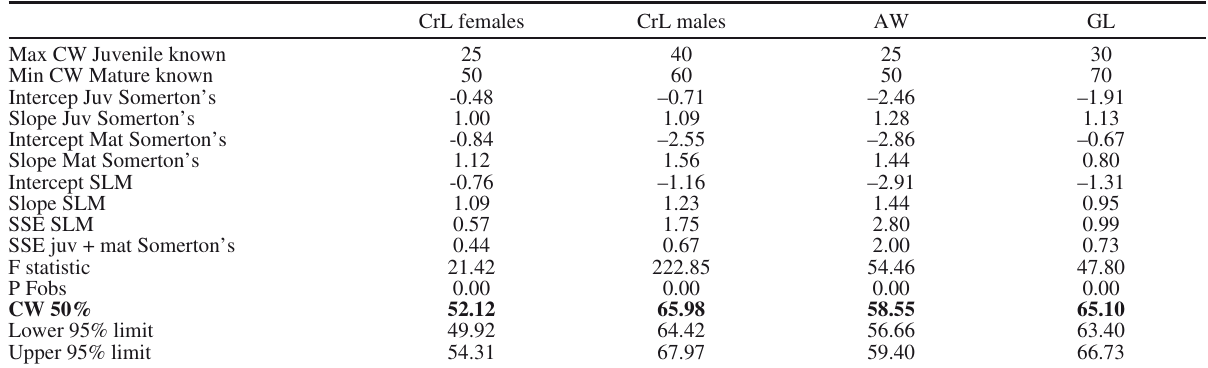
Table 2. – Summary of statistics and estimated parameters of the simple linear model and two-phase linear model (Somerton’s method fit- ted using the MATURE program) applied to the four morphometric characters used to estimate first maturity of both sexes of Platyxanthus crenulatus . SLM, simple linear model; SSE, sum of squared errors. Somerton’s immature or juvenile (Juv) and mature (Mat) are the first and second segments of the two-phase linear model, respectively. CW, carapace width; CrL, length of the propodus of the crusher; AW,